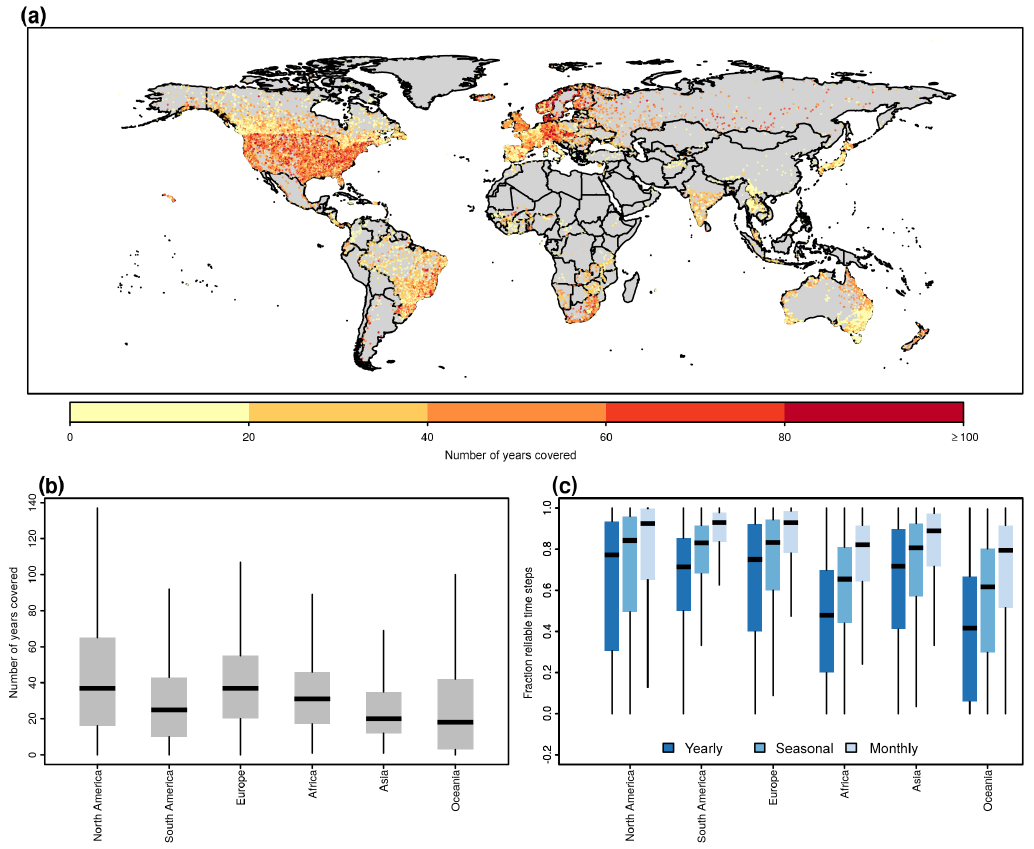
Figure 4. Temporal coverage of streamflow time-series indices. (a) Map of the number of years covered by each time series under consider- ation. (b) Distribution of the number of years available per time series for the continental regions of the world. (c) Distribution of the fraction of time steps that are classified as reliable using the ECA&D13 data availability criteria. Boxplots show the interquartile range (box) and the median (vertical bar); the whiskers extend to the most extreme point, which is not more than 1.5 times the interquartile range away from the box; outliers are